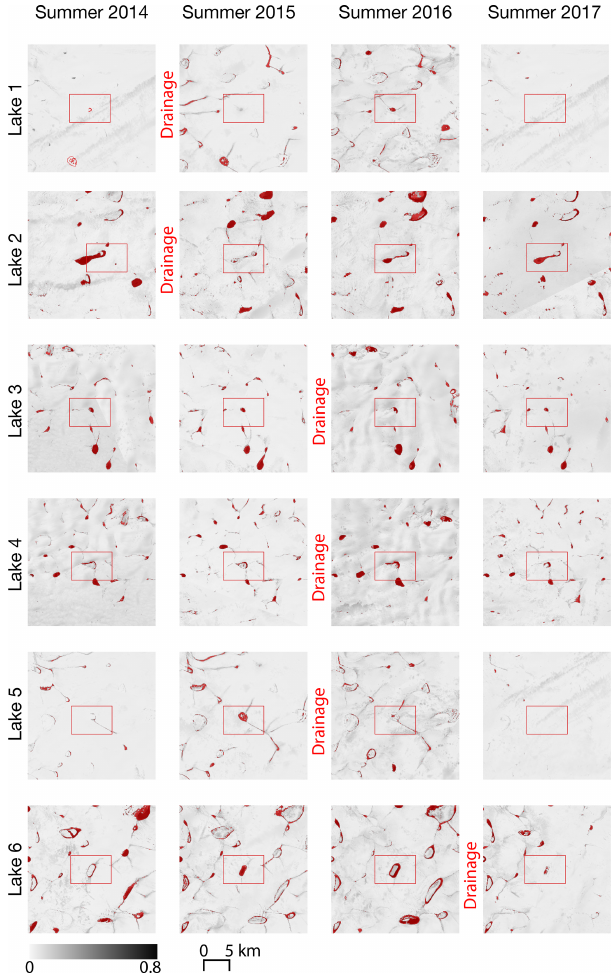
Figure C1. Composite maximum NDWI ice images for each sum- mer. Each pixel shows the highest NDWI ice reached for that pixel for the season. The red outlines show the lake outlines as delineated by a threshold exceeding 0.25 in the maximum NDWI ice composite for the pre-drainage summer. Red boxes identify each anomalous